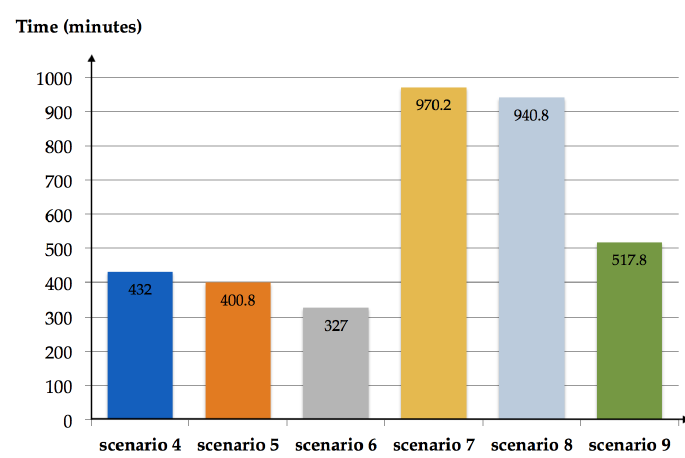
Figure 16. Training time in minutes for Scenarios 4 to